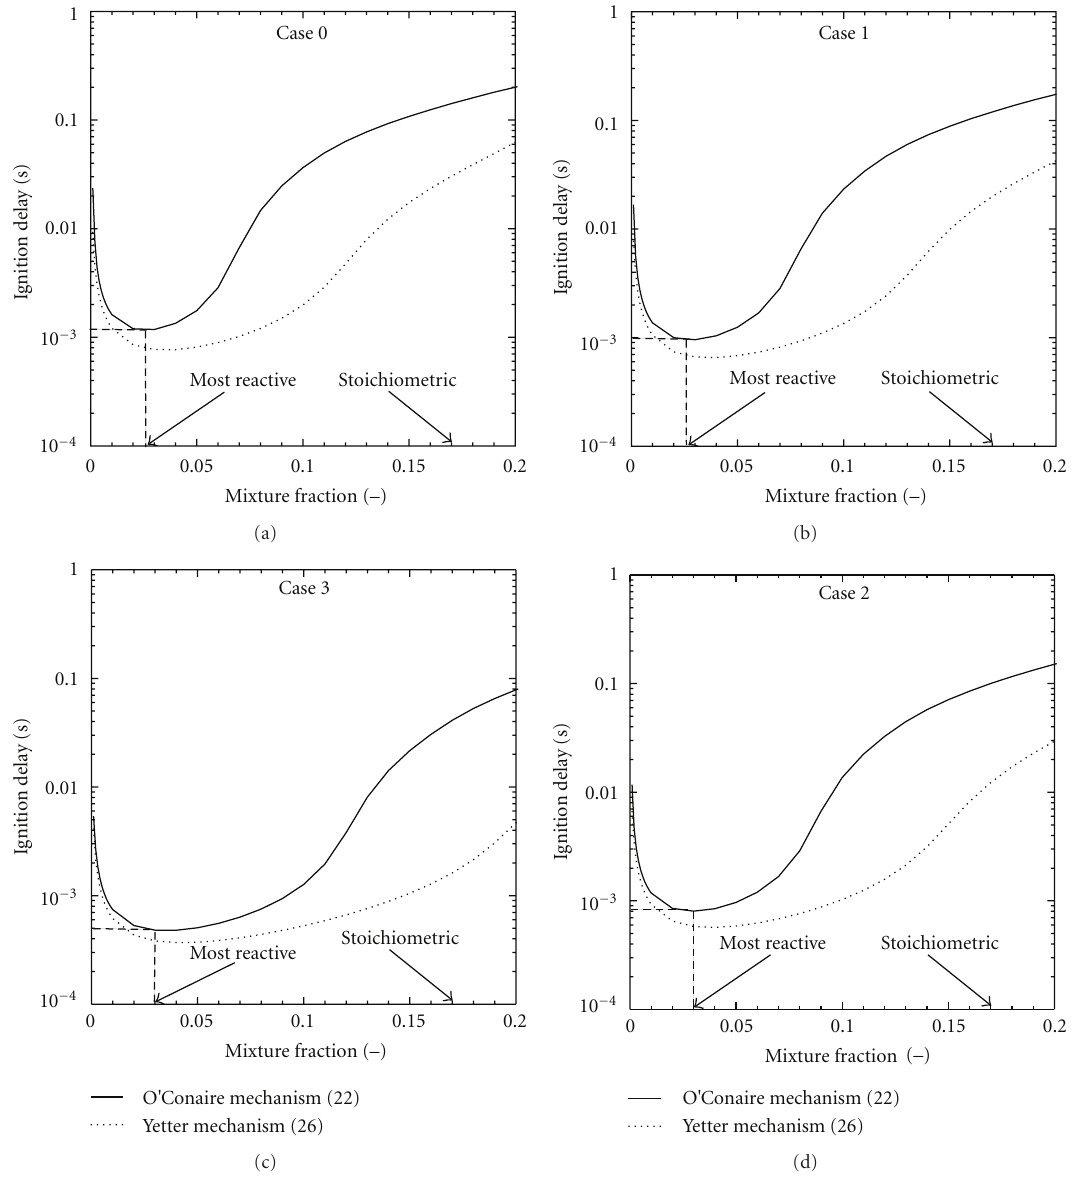
Figure 3: Most reactive mixture fraction based on ignition delay times predicted by di ff erent mechanisms for the cases described in Table